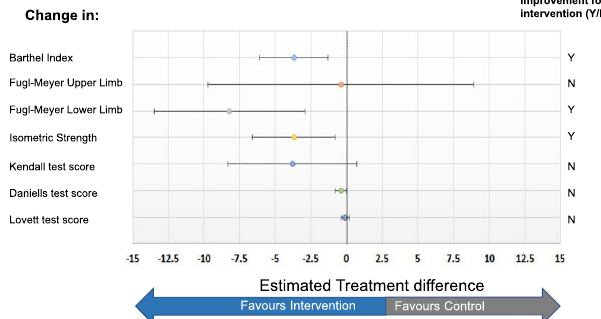
Figure 4. Changes in Barthel index for daily living activity test and the muscle strength functionality tests after 12 weeks of treatment. Forest plot shows estimated treatment differences (ETDs)/odds ratios and 95% CIs. Data are from the full analysis set (completers subjects of control and sEMG-B groups). Data at baseline are mean ± s.d. Improvement/worsening refer to the statistically significant changes from baseline with sEMG-B intervention relative to the control group. Precise data and statistical significance values are available in Supplementary Information Table